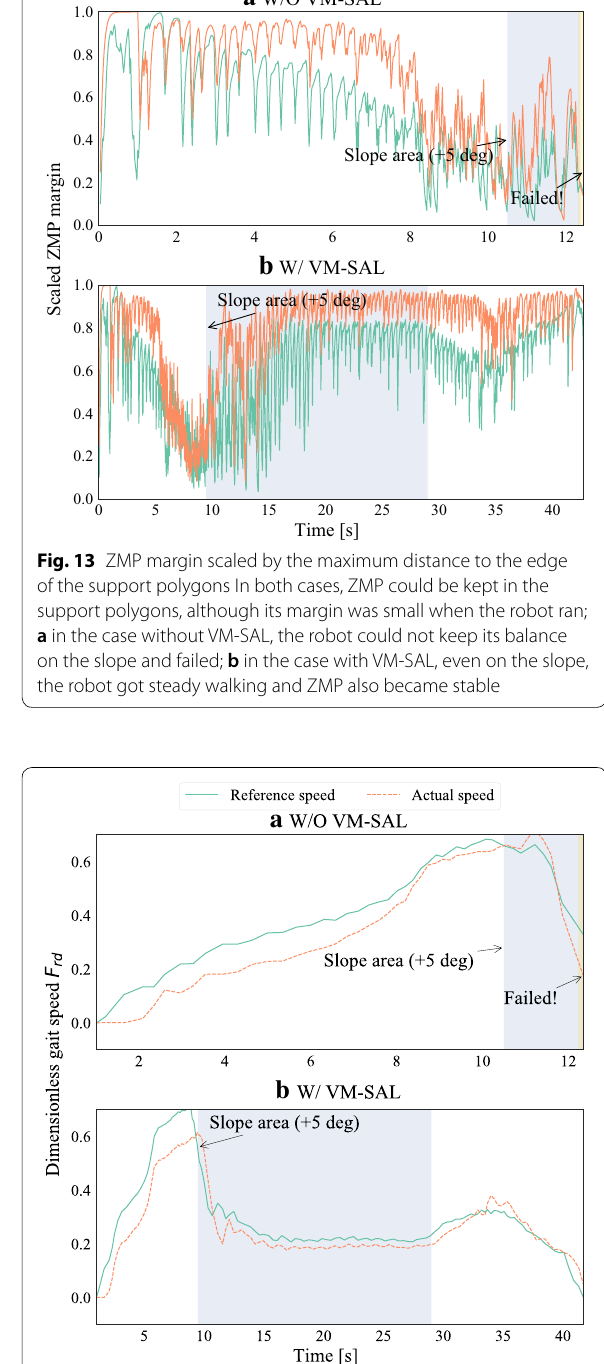
Fig. 14 Reference and actual forward gait speed a the robot fell down just after stepping into the slope because on delayed deceleration; b the gait speed was decelerated before stepping into the slope, and kept low for